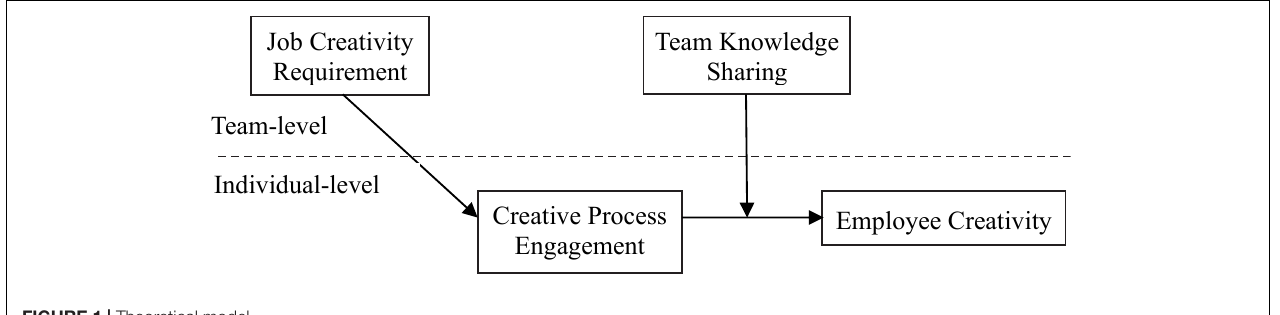
FIGURE 1 | Theoretical